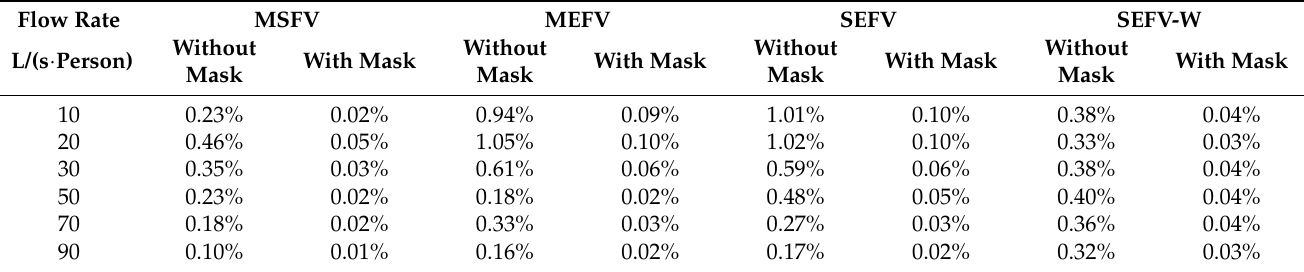
Table 2. Inhaled fraction of medical staff under different ventilation strategies IF × 100%.